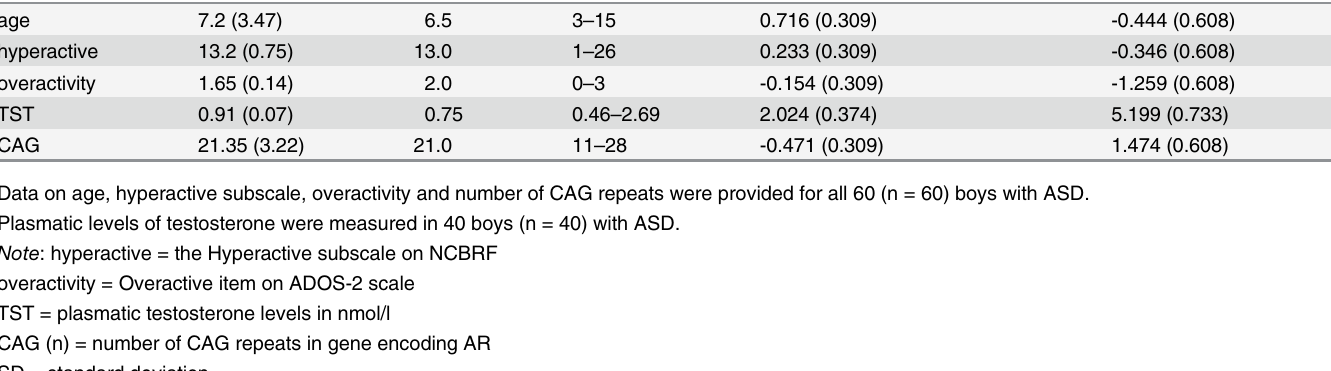
Table 1. Descriptive statistics of observed parameters in the whole sample of boys with ASD.